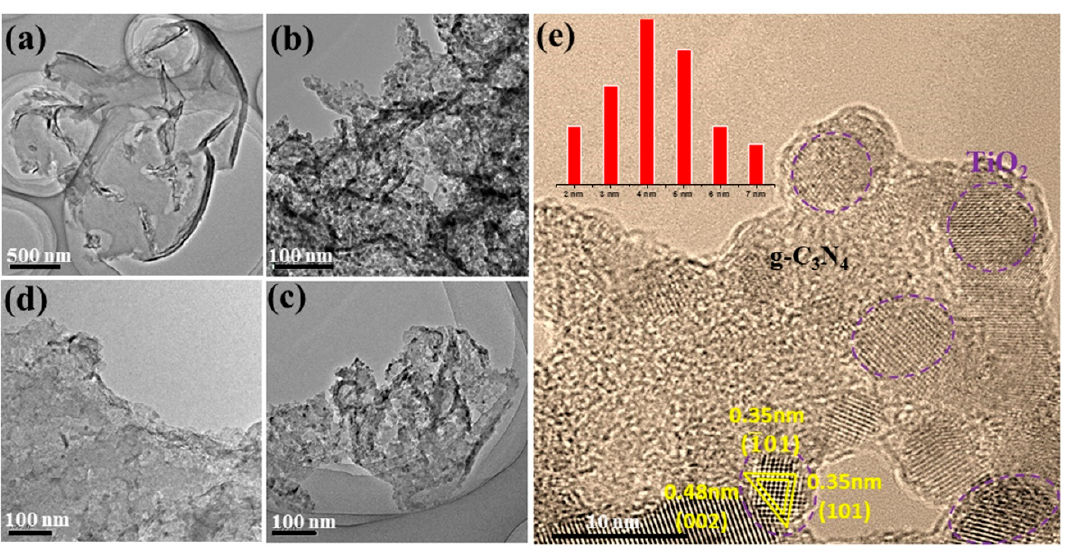
Figure 2. TG profiles of bulk g-C 3 N 4 , TiGly and TGC- x.